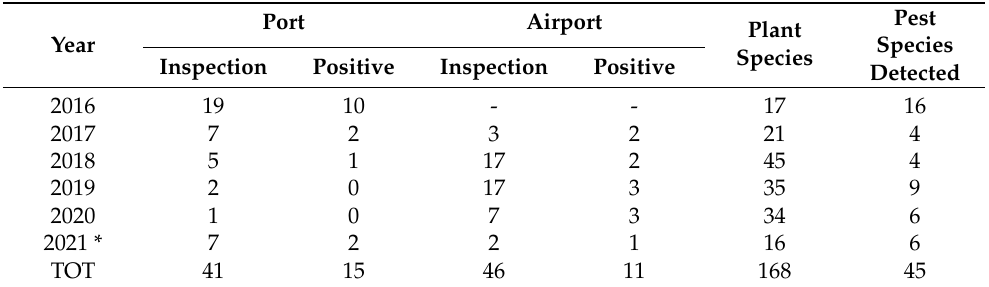
Table 1. Number of inspections from 2016 to 2021 and respective number of detected pests in fruits, seeds, parts of plant, wood, and other plant materials. * Data refer to the first half of 2021.